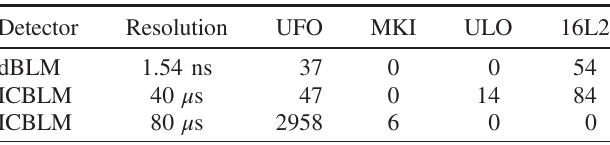
TABLE I. Validated UFO events collected during Run II. The ICBLM measurements are a subset of validated measurements as detailed in the